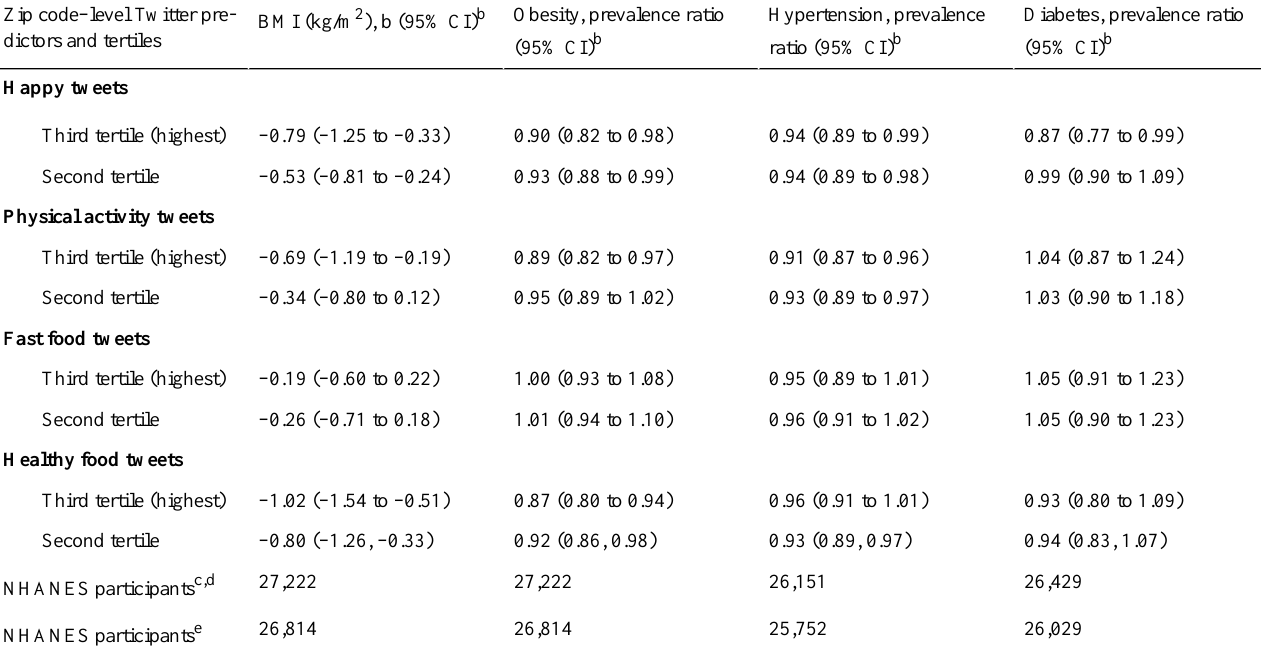
Table 5. Twitter-derived neighborhood characteristics and adult health outcomes in full cohort a .